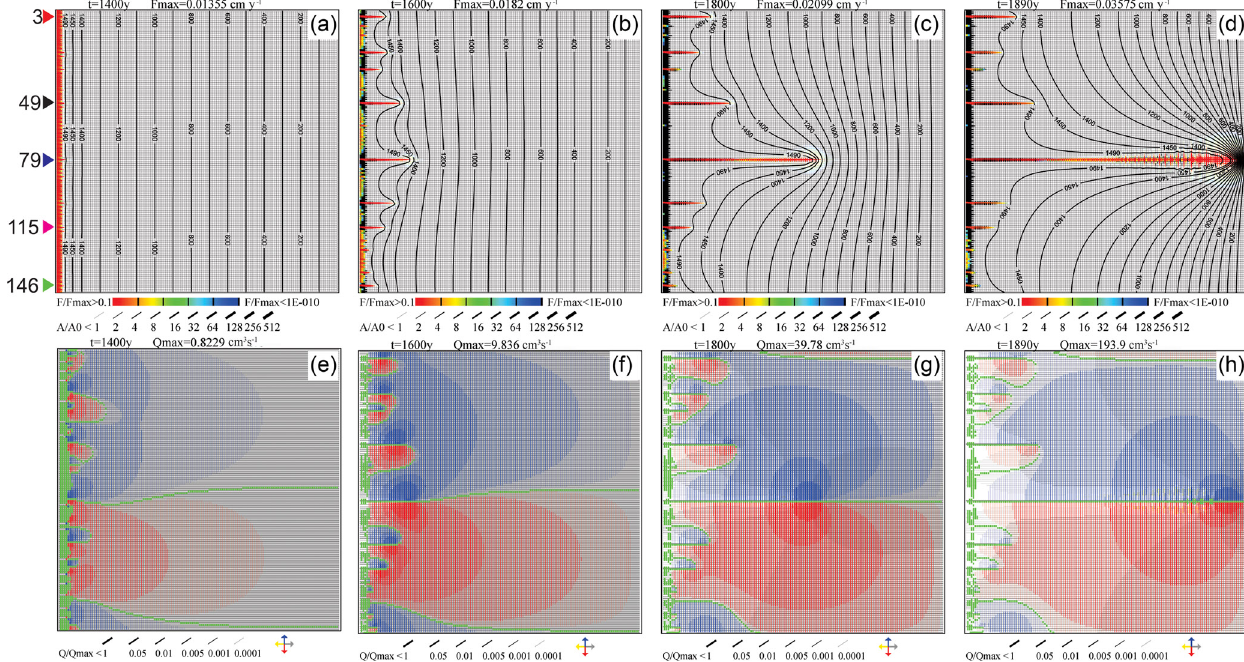
Figure 3. Temporal evolution of a uniform fracture network. Panels in the upper row show aperture widths as line thickness and relative dissolution rates (a ratio between the rate in a fracture and the highest dissolution rate F max in the network) given in the color code. Lower panels show relative flow rates (ratio between the flow rate in a fracture and flow rate Q max in the fracture with maximal flow in the network) and flow directions as shown by the arrow code. Green lines denote the flow divides by connecting nodes with opposite direction of outflow. White regions depict zero flow. Colored triangles mark the position of inputs where later wormholes evolve (See also Fig. 4). Numbers denote their y coordinate.